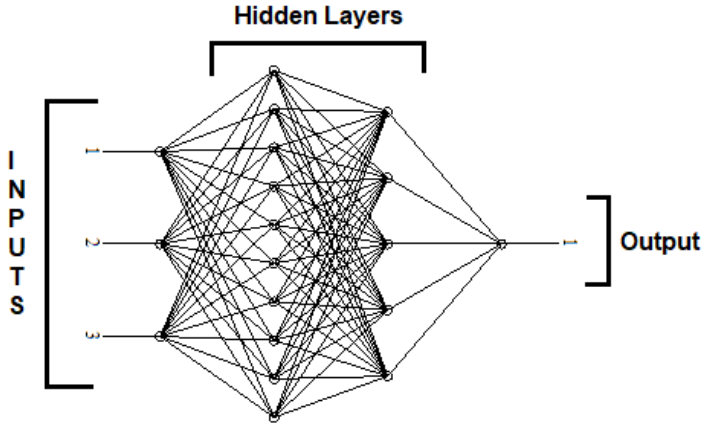
Figure 14. ANN architecture (3(inputs)-10(hidden layer)-5(hidden layers)-1(output)).